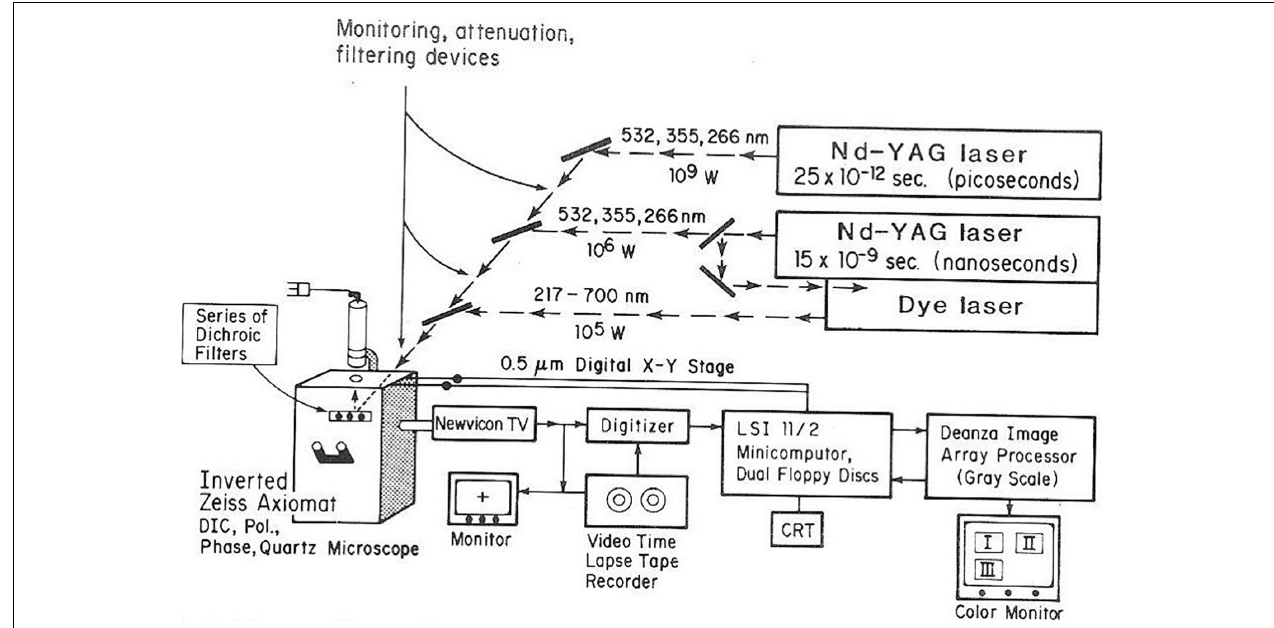
FIGURE 4 | NIH LAMP P41 Biotechnology Resource laser microbeam system circa 1981. The lasers are a Quantel YAG 400 picosecond and nanosecond multi-harmonic device used to pump a tunable dye laser. The microscope is an inverted Zeiss Axiomat equipped with phase, bright field, polarization, and DIC optics. The digital imaging system uses a LSI-II driven Deanza IP 500 array processor interfaced with GYRR DA MKIII time-lapse videotape system. The LSI-II also controls the X-Y-Z microscope digital stage as well as image acquisition providing cell tracking capabilities. This system was replaced with the laser scissors-trapping system RoboLase system circa 2005 (see Figures 8 , 9